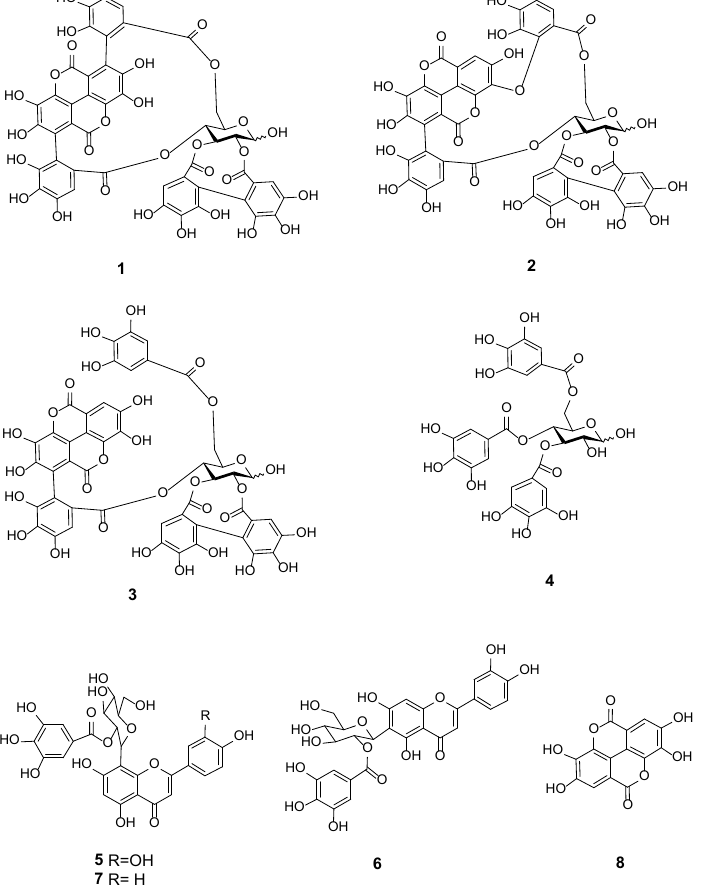
Figure 4. Chemical structure of polyphenolic compounds ( 1 – 8 ) identified in Terminalia bentzoë L. leaf extract.